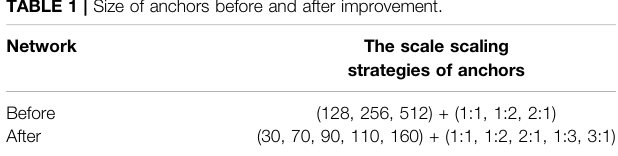
TABLE 1 | Size of anchors before and after